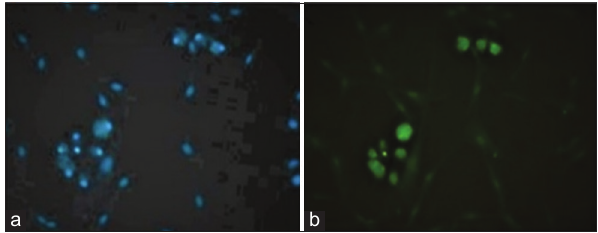
Figure-3: Adipose stem cells from dogs naturally infected with canine morbillivirus. (a) 4’,6-Diamidino-2-phenylindole dye and (b) direct immunofluorescence using anti-canine distemper virus antibody